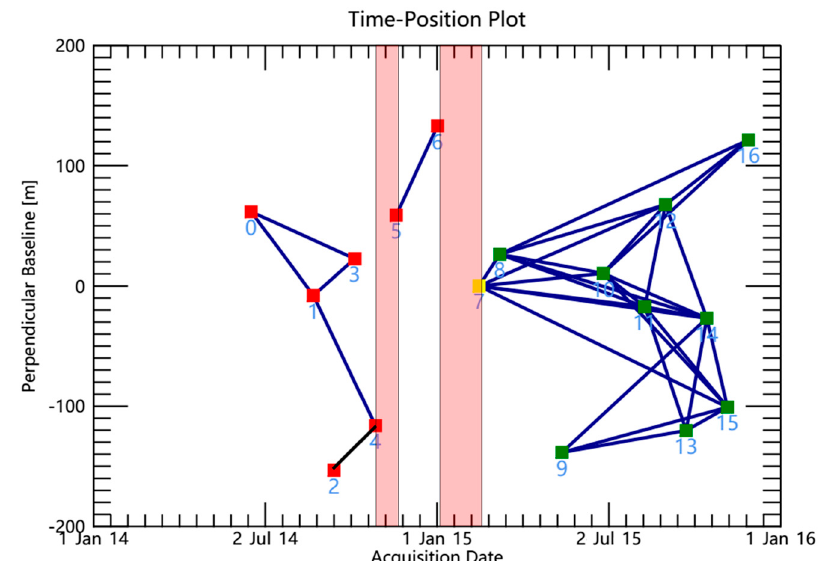
Figure 5. Temporal and perpendicular baselines of the final selected InSAR pairs (X axis defines the temporal baseline, Y axis defines the perpendicular baseline. Number 0–16 define the corresponding TerraSAR images in our article, the yellow point 7 is the super master image selected, the red pillar areas are the gaps, not covered by any suitable interferometric pairs). Table 2. Quantitative comparison of accuracy for 4